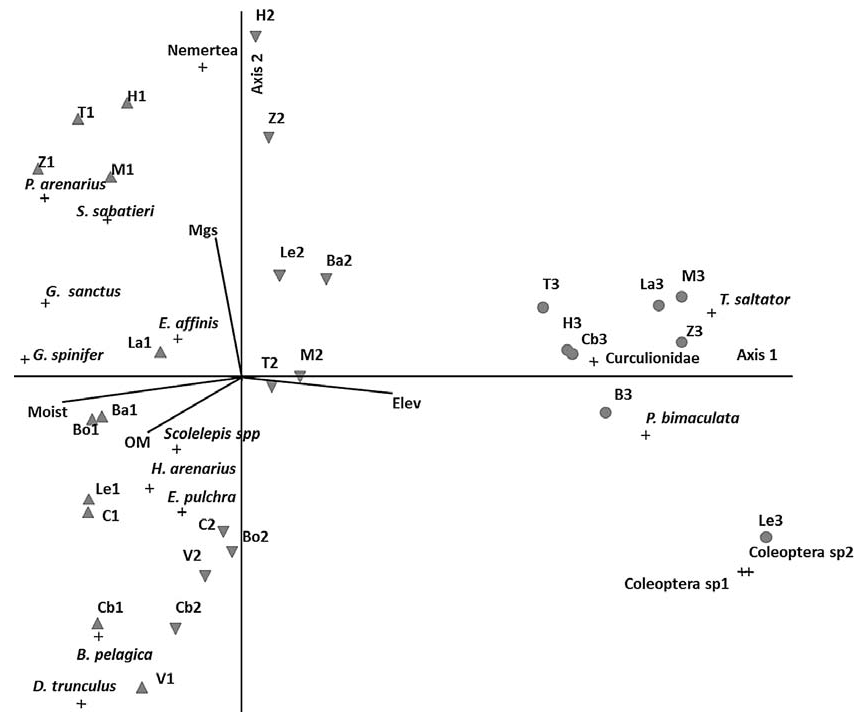
Fig. 5. – Triplot resulting from CCA analysis. Crosses show the most abundant species in each zone. The lower zones are represented by tri- angles, the middle zones by inverted triangles and the upper zones by circles. Arrows represents explanatory variables (Moist, sand moisture; Mgs, median grain size; Elev, elevation; OM, organic matter